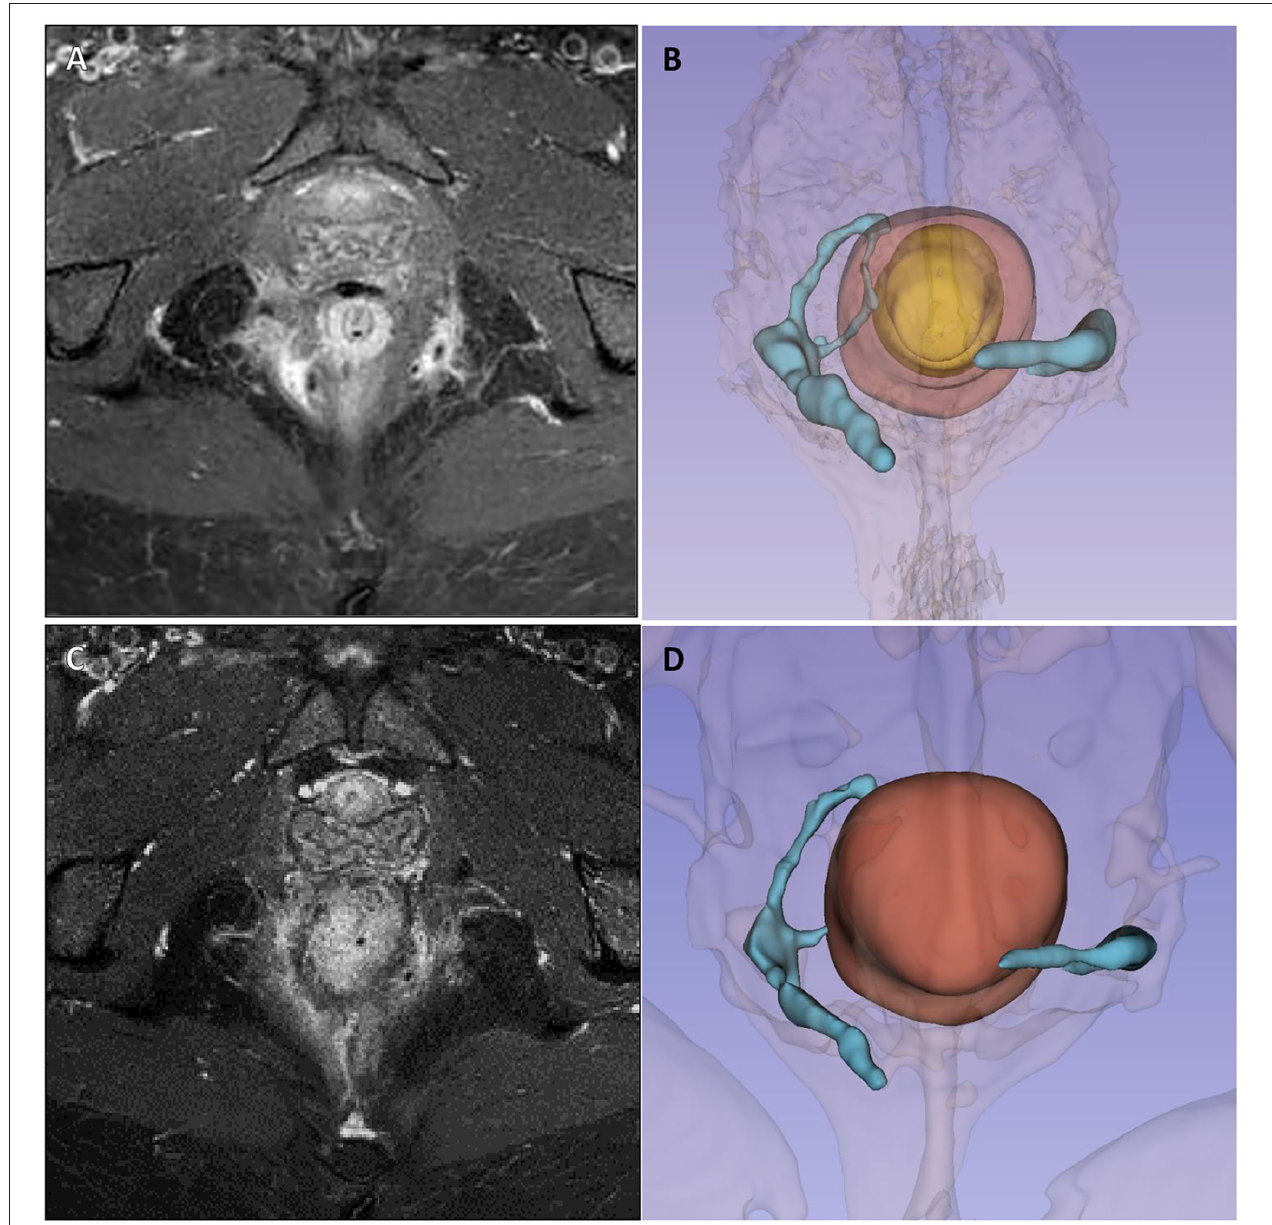
FIGURE 3 | Case 2 imaging pre- and post-surgery. Panels (A, B) show pre-operative pelvic magnetic resonance imaging and 3D reconstruction showing two active complex trans-sphincteric fistulas: on the left a trans-sphincteric fistula with a seton in place, and on the right a branched trans-sphincteric fistula with an abscessual cavity of 17 × 10mm in the ischioanal space and a single external orifice in the posterior right perianal quadrant (h8). Panels (C, D) show 6-month MRI follow-up, with persistence of fistula tracts but with less thickness and no related